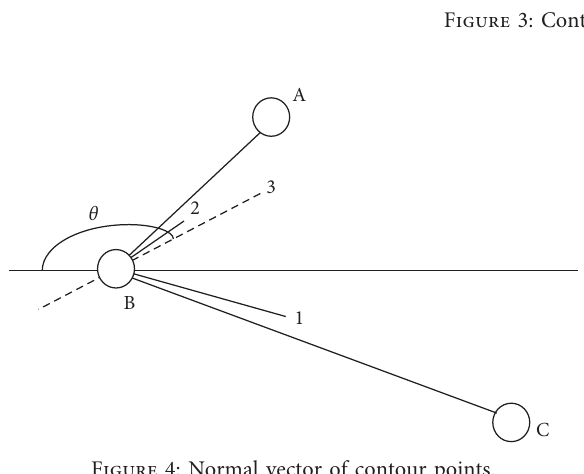
Figure 4: Normal vector of contour points.